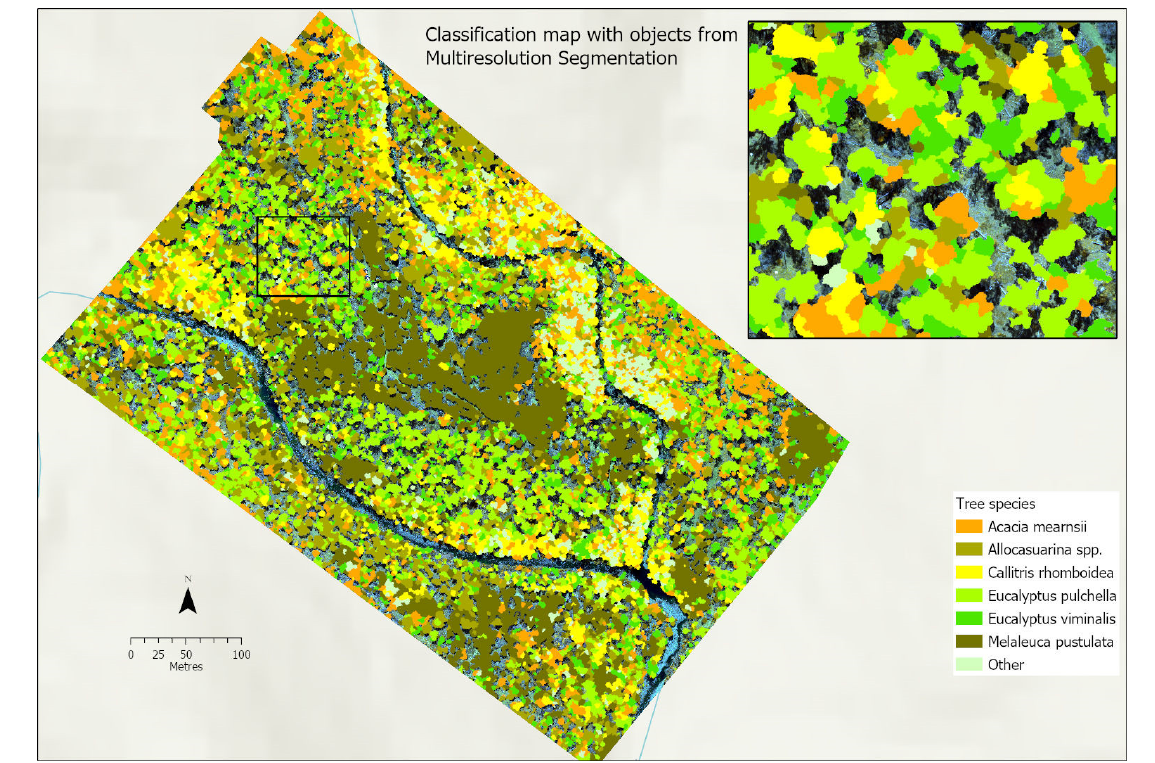
Figure 9. Classification map using MRS objects. Pulchella dominated forest subset shown in inset. Speckle effect less prevalent at a coarser scale of analysis than superpixels.